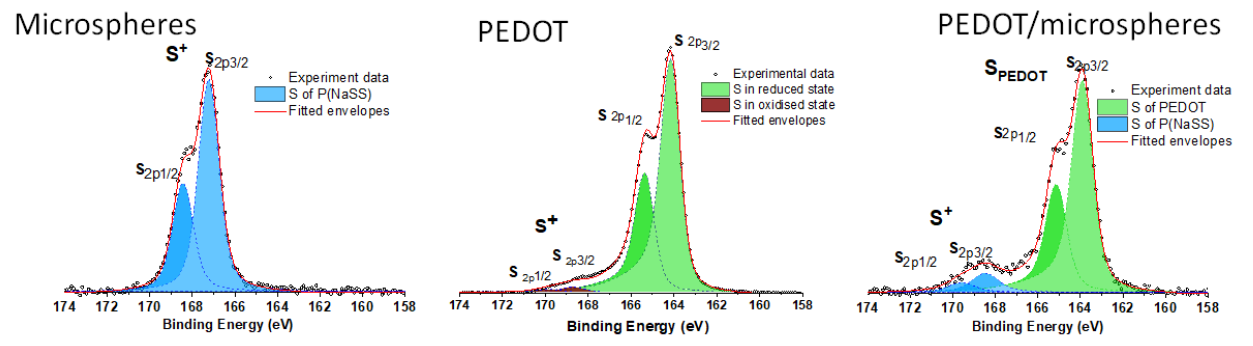
Figure 2. High-resolution core-level S2p X-ray photoelectron spectra of core microspheres, PEDOT and PNaSS@PEDOT microspheres.